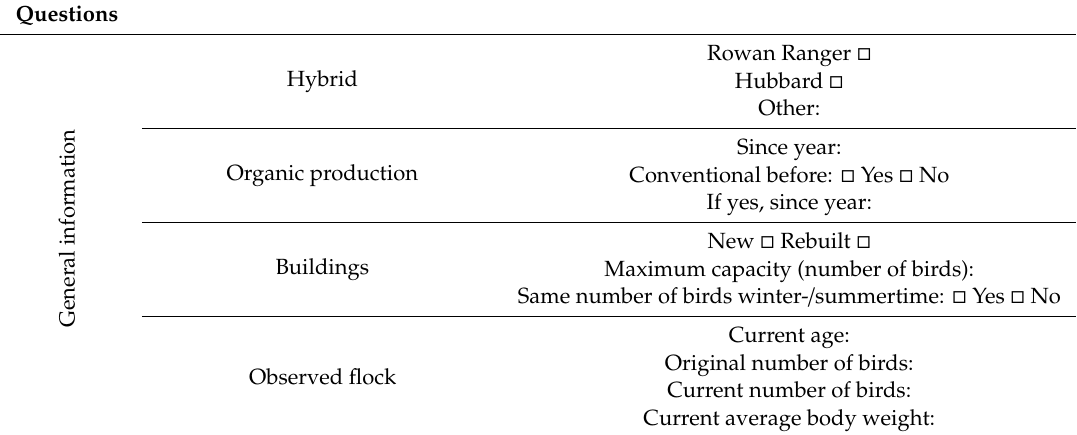
Table A1. Questionnaire used in interviews with farmers on Swedish organic broiler chicken